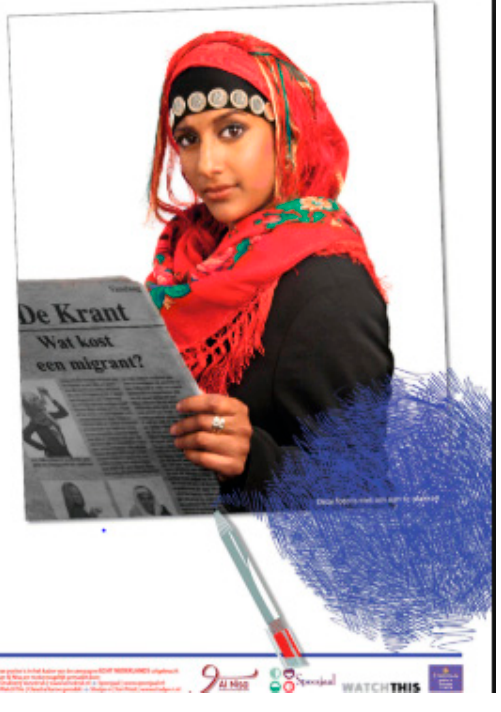
Image 2: “Real Dutch?” Poster Campaign by Al Nisa